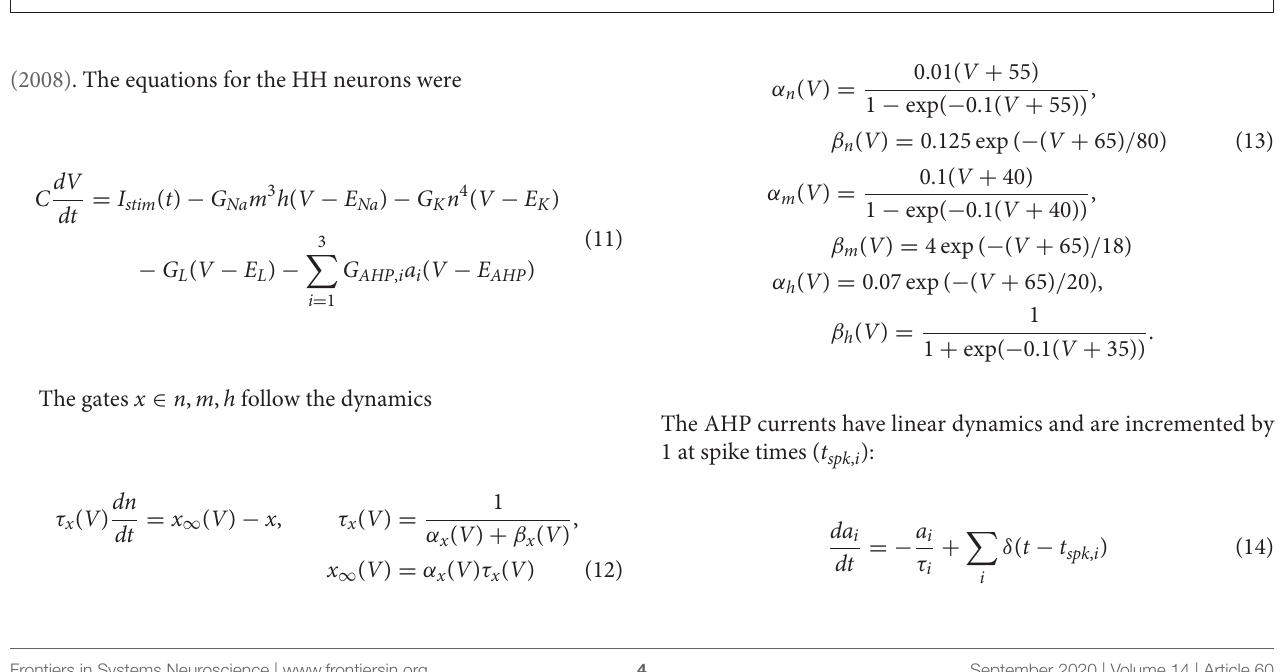
FIGURE 1 | (A) The voltage ( V ), stimulus current ( I s tim ), and stimulus filtered by the STA ( s ) for Hodgkin-Huxley simulations of a neuron stimulated with white noise at two different standard deviation levels (black σ = 1; red σ = 2). In this simulation, the total sodium and potassium conductances were equal ( G Na = G K = 1,000 pS / µ m 2 ). (B) The STAs measured at the two stimulus standard deviations. (C) Left shows the spike-triggered distributions of the STA filtered input ( s ) and right shows the distributions over the STA filtered input scaled by the standard deviation ( ˆ s ). The shaded areas show the prior stimulus distributions, which are Gaussian distributed with standard deviation σ . (D) The input-output functions of the stimulation at each stimulus level. Scaling the input by the standard deviation shows that the simulated neuron scales the gain of the input by the stimulus standard deviation (right). (E) The STAs measured at two standard deviations from a Hodgkin-Huxley simulation with high potassium and low sodium total conductances ( G Na = 600 and G K = 2,000 pS / µ m 2 ). The spike-triggered stimulus distribution (F) and scaled input-output function (G) for this simulation does not show gain